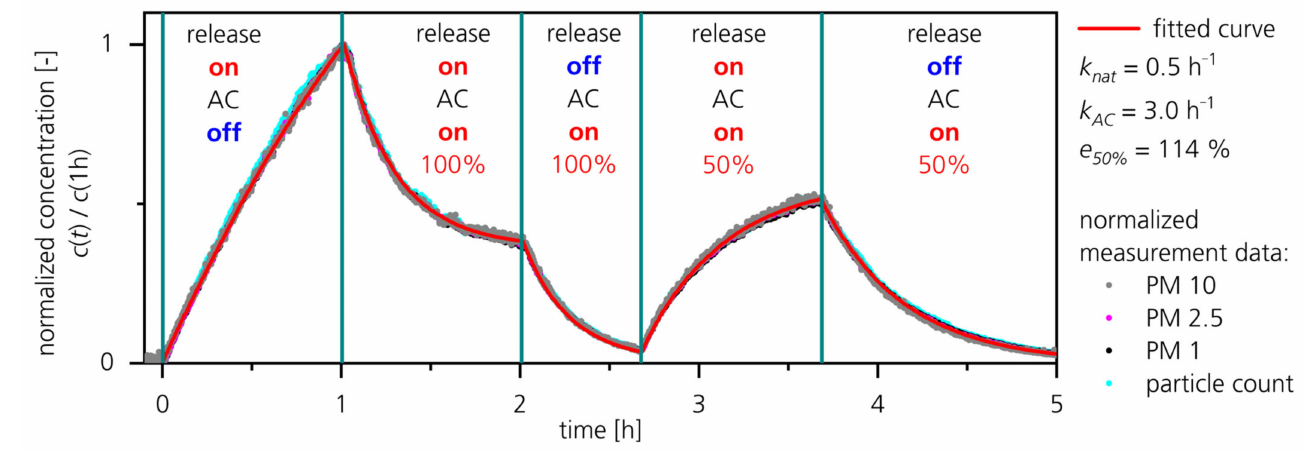
Figure 3. Determination of the coefficient k AC of an air cleaner (AC) in a well-mixed room. The natural loss coefficient is determined between 0 and 1 h. (Fitting process see Section